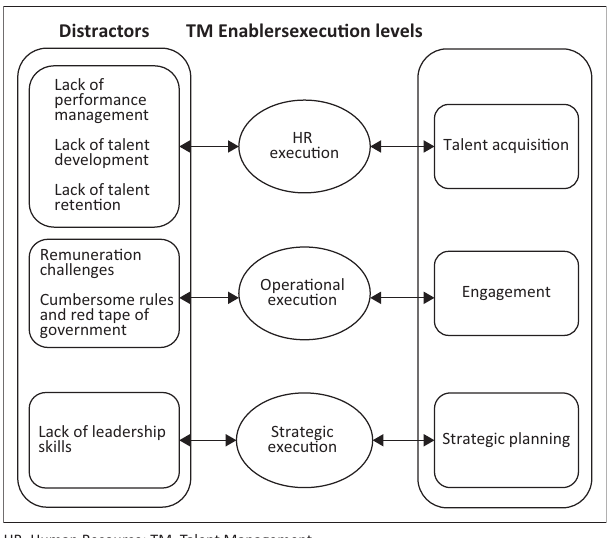
FIGURE 1: Conceptual framework of talent management execution in the Ministry of Justice in the Namibian public